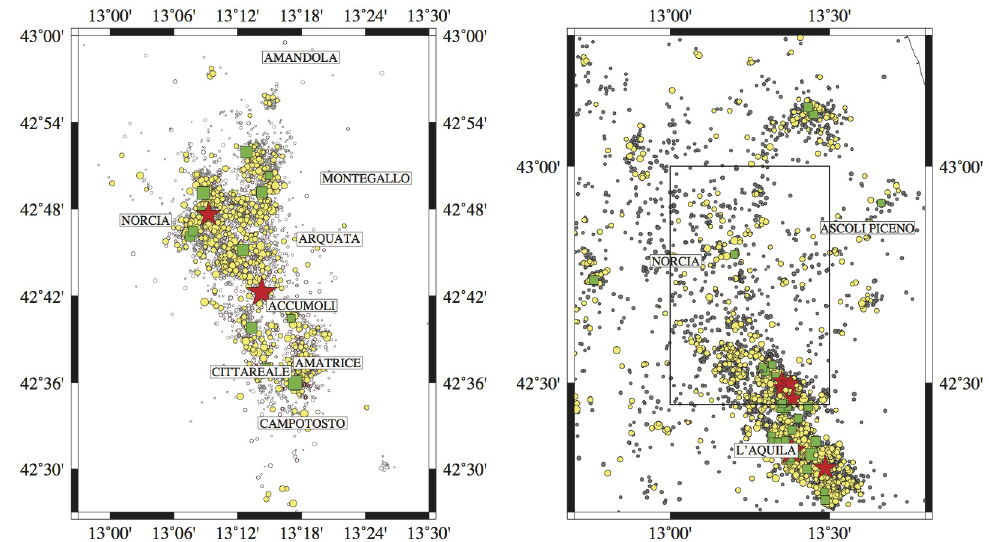
Figure 1: Map of the seismicity occurred in the area interested by the 2016 Central Italy sequence. Gray and yellow circles mark the events with magnitudes ML < 2.5 and 2.5 ≤ ML < 4.0 , respectively. Green square and red stars marks the events with magnitude 4.0 ≤ ML < 5.0 and ML ≥ 5.0 , respectively. The left panel show the first 20 days of the 2016 sequence (August 24 - September 15) in the area struck by the sequence [12.95-13.5E, 42.45-43.0N]. In the right panel the seismicity occurred before the 2016 sequence (April 16 2005 - August 24 2016) in the larger area [12.7-13.8E, 42.0-43.5N], used to estimate the ETAS model, is shown (the square identifies the area interested by the 2016 sequence). The strongest events in the southern part refer to the 2009 L’Aquila